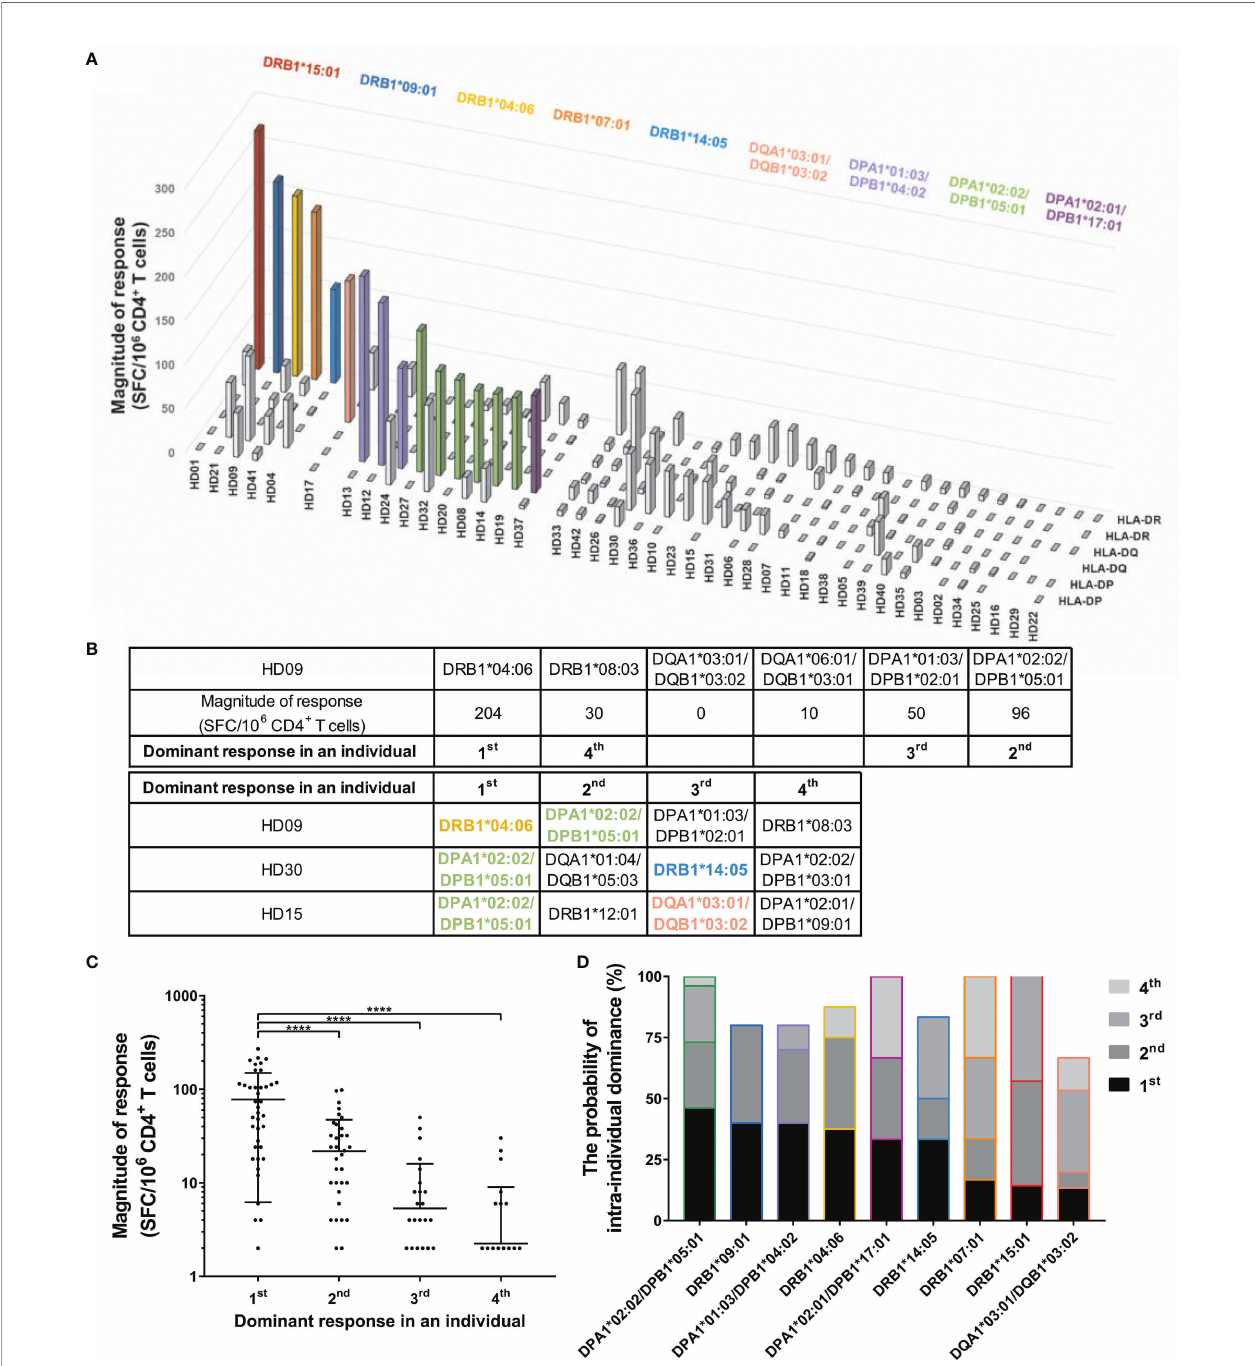
FIGURE 2 | CD4 + T cell responses restricted by single HLA class II allotype within individuals. CD4 + T cells were stimulated with an allotype-matched aAPCs pulsed with a mixture of peptide pools of spike, nucleocapsid, and membrane protein. (A) CD4 + T cell responses (vertical) by two allotypes of HLA-DR, -DQ, and -DP loci (depth) in each individual (horizontal). The magnitude of response above 50 SFCs/5 × 10 5 are colored and the alleles corresponding to the response are shown in the same color. (B) A schematic diagram of the analysis of dominant response in individuals. (C) The order of highest response by an allotype within an individual is presented as the dominant response in an individual. Each dot represents a response by an allotype. Data are shown as mean ± standard deviation (SD) of the order-speci fi c response. Statistical analysis was performed using one-way ANOVA. ****P < 0.0001. (D) The probability of intra-individual dominance presents (the number of donors with the corresponding order from the responses by the allotype)/(the number of donors with the allotype). The donors who did not respond by any allotype were excepted. The order and color of the allele follow (B) and (A) ,